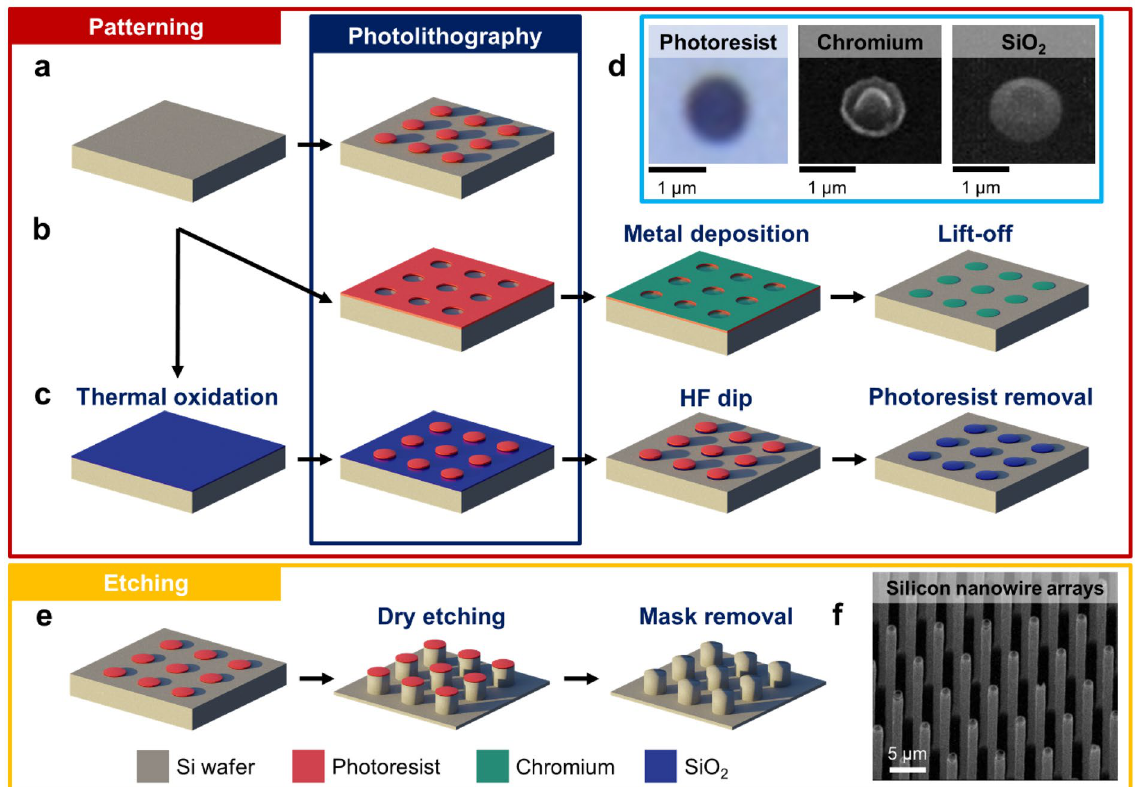
Figure 1. Fabrication routes of vertical silicon (Si) nanowire arrays using different mask materials. Patterning of ( a ) photoresist, ( b ) chromium (Cr), and ( c ) silicon dioxide (SiO 2 ) masks combines photolithography and several thin-film fabrication techniques (i.e., electron-beam evaporation for Cr thin film and wet thermal oxidation for SiO 2 thin film). ( d ) The resulting photoresist, Cr, and SiO masks on Si substrates showing circular patterns with a diameter of ~1 µm. ( e ) Inductively coupled plasma reactive ion etching (ICP-RIE) process of